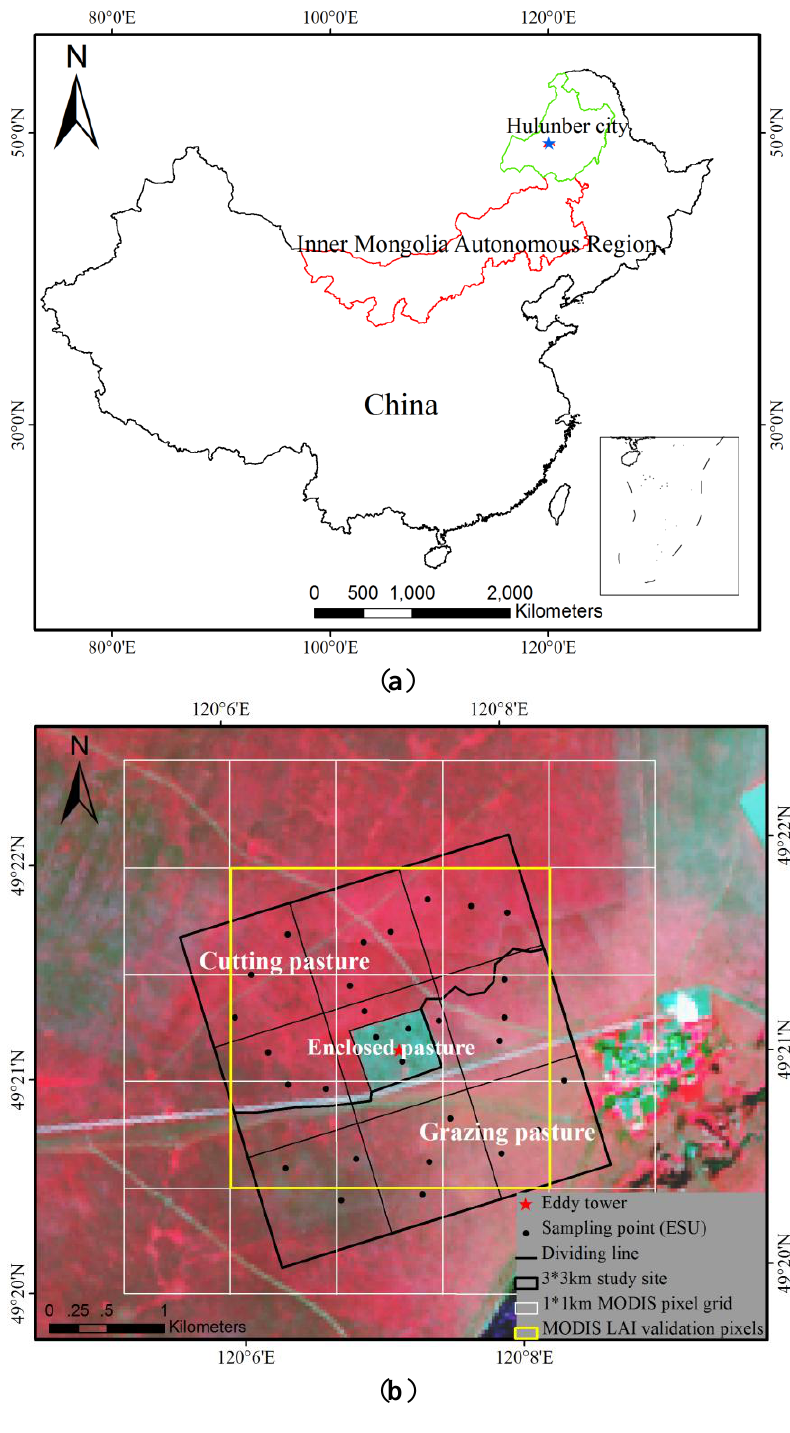
Figure 1. Site location and sampling points (background: Landsat-8 OLI